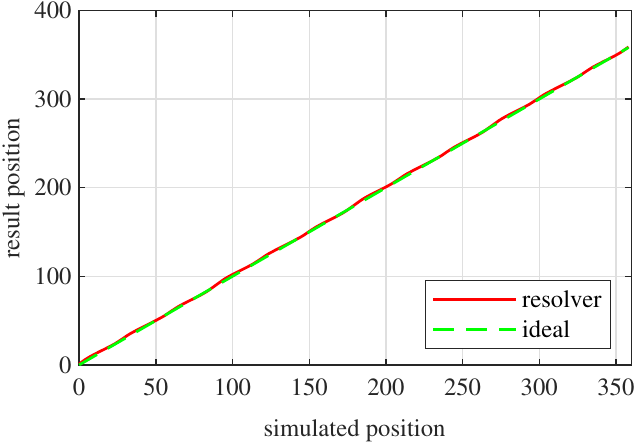
Figure 26. Full pitch twelve-slot skewed resolver position vs. the ideal position.